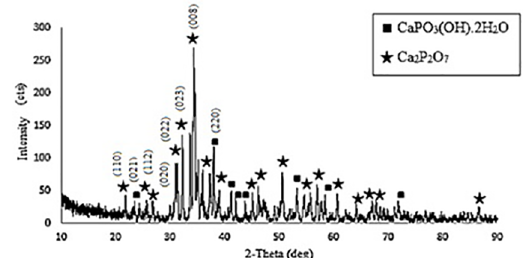
Figure 3. The XRD diffraction pattern of the calcined materials in 700 ºC Fig. 4 shows the SEM image of the calcined Ca(OH)